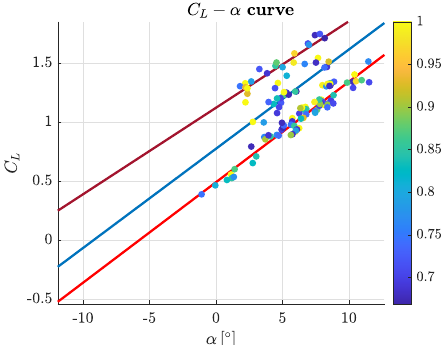
Figure 10. C L − α plot, global view of the three regression lines (the color scale refers to the score assigned to each